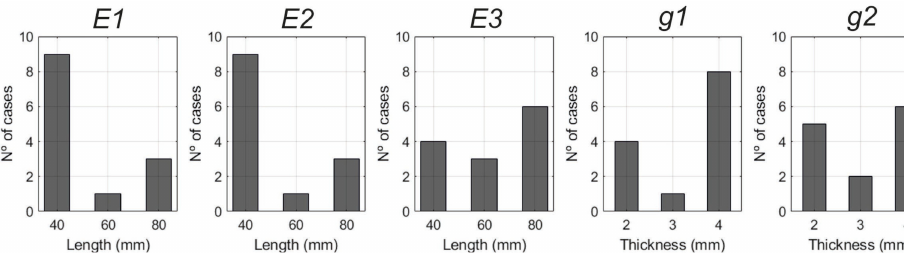
Figure 15. Variables values of frequent input data in best performance